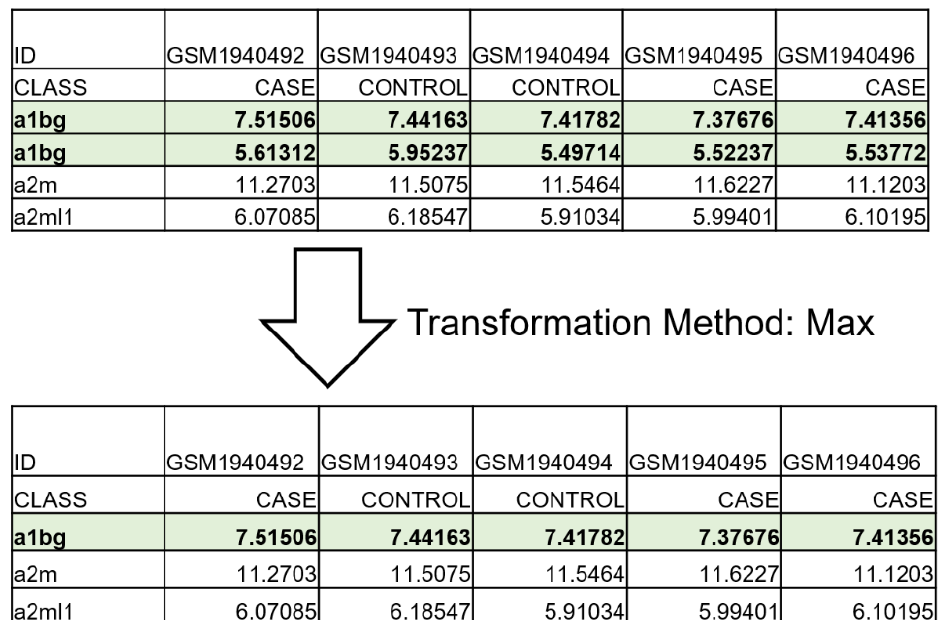
Figure 2. An example of how GISU transforms probes to gene identifiers. Two probe identifiers correspond to the same gene identifier (highlighted gene identifier). In this case, the max transformation method is applied. For each subject, the largest values remain in the final dataset, and the other is deleted.